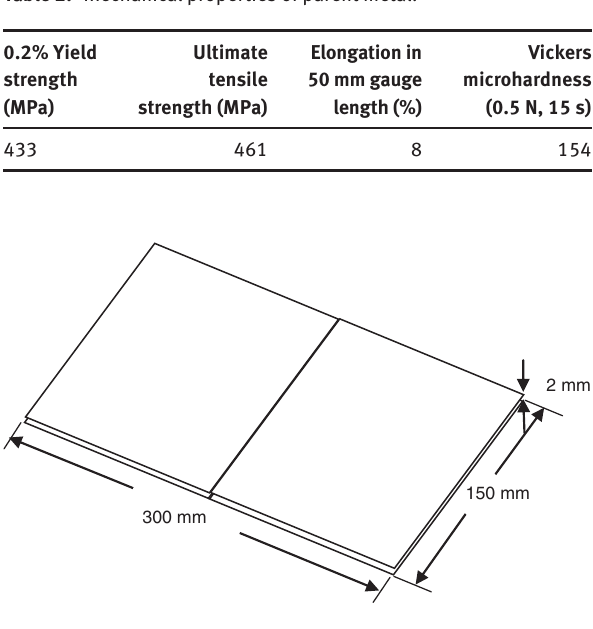
Figure 1: Schematic diagram of FSW joint